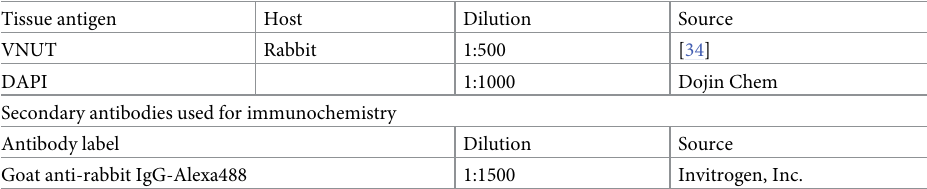
Table 2. Characteristics of primary and secondary antisera used for